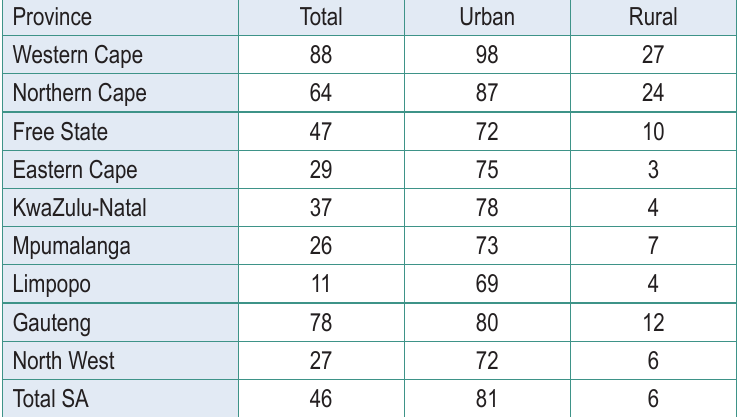
Table 1: Percentage of houses with access to sanitation (1993) ¹ Province Total